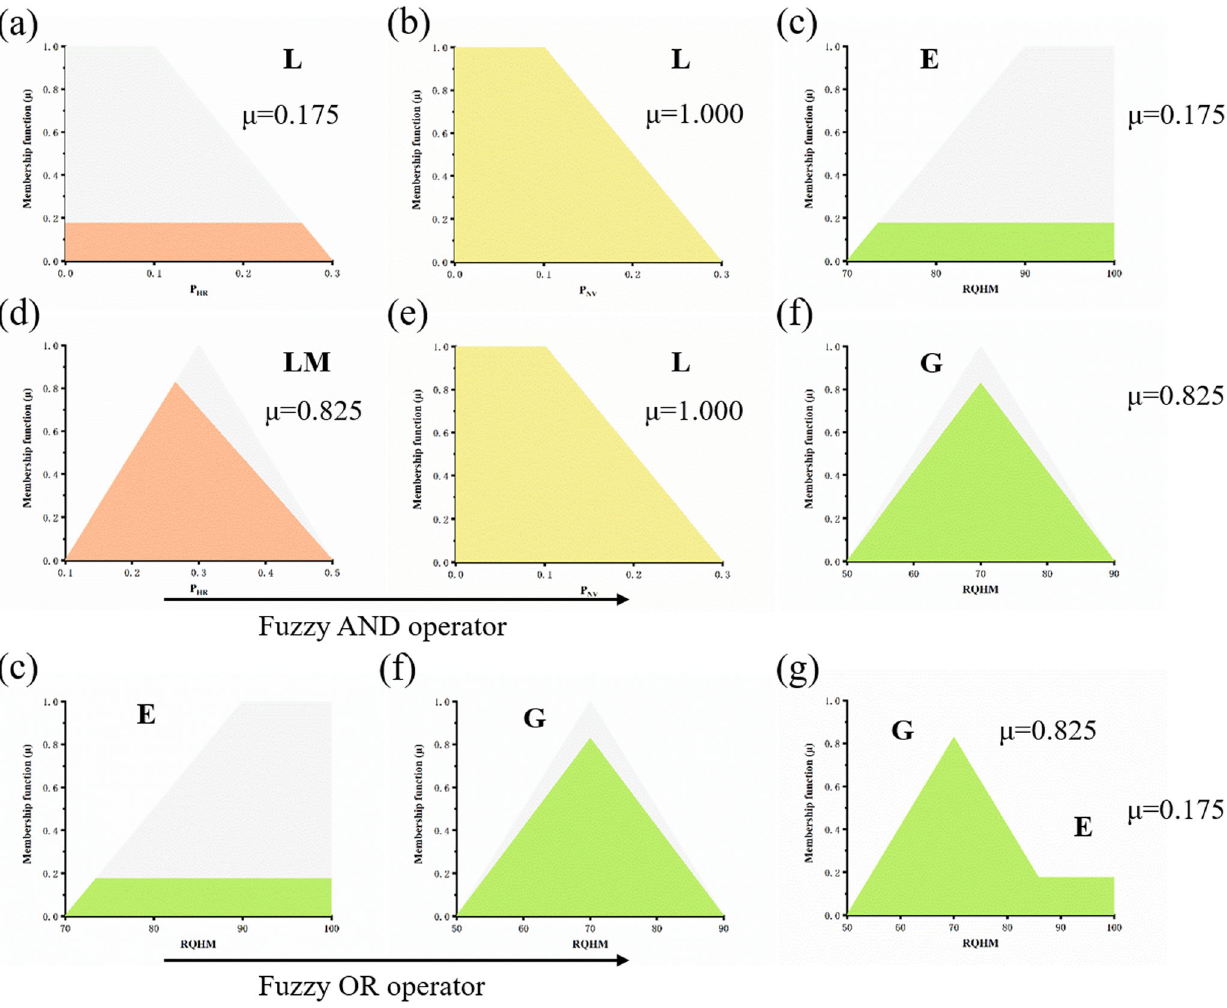
Fig. 4 Fuzzy inference process in Heilongjiang Province. [Note: a , d : health risks identi fi ed using health risk guidelines (pink); b , e : nutritional value impact (yellow); c , f , g : the rice quality – heavy metal(loid) (RQHM) score (green). The fuzzy AND operator of a and b and of d and e were used to obtain c and f ; the fuzzy OR operator of c and f was used to obtain ( g ); μ indicated critical level, which was obtained by mapping the exceeding probability to the fuzzy membership function. The pale gray shading represented the initial fuzzy membership function, and the bright shading represented the fuzzy graph obtained by mapping the critical level into the fuzzy membership